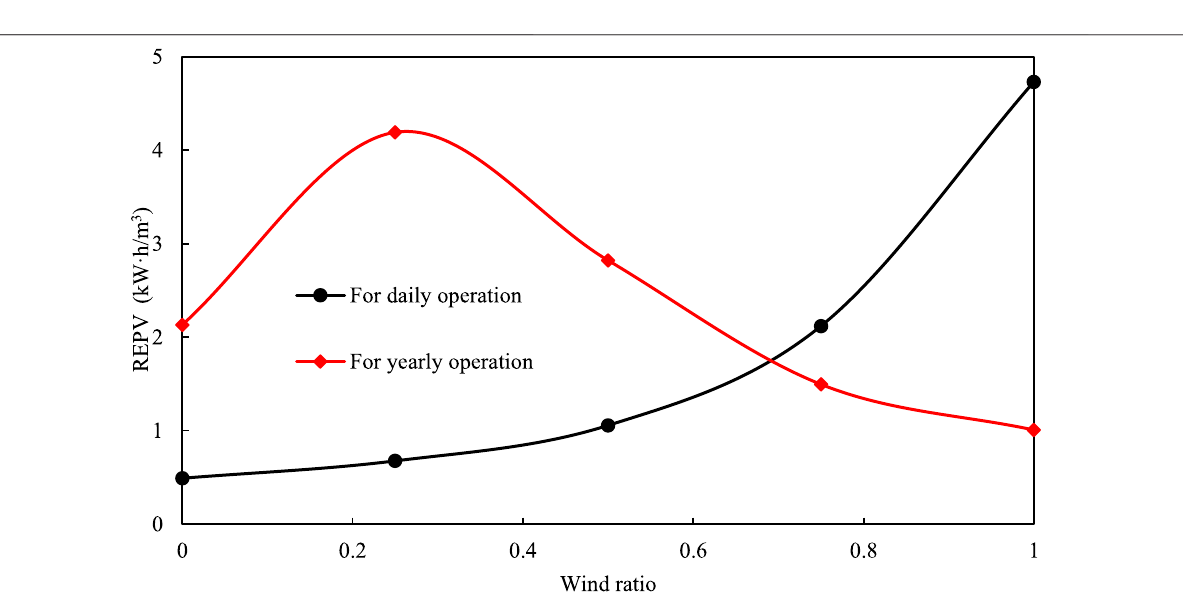
FIGURE 13 | Regulating energy density ( REPV ) variation with different wind